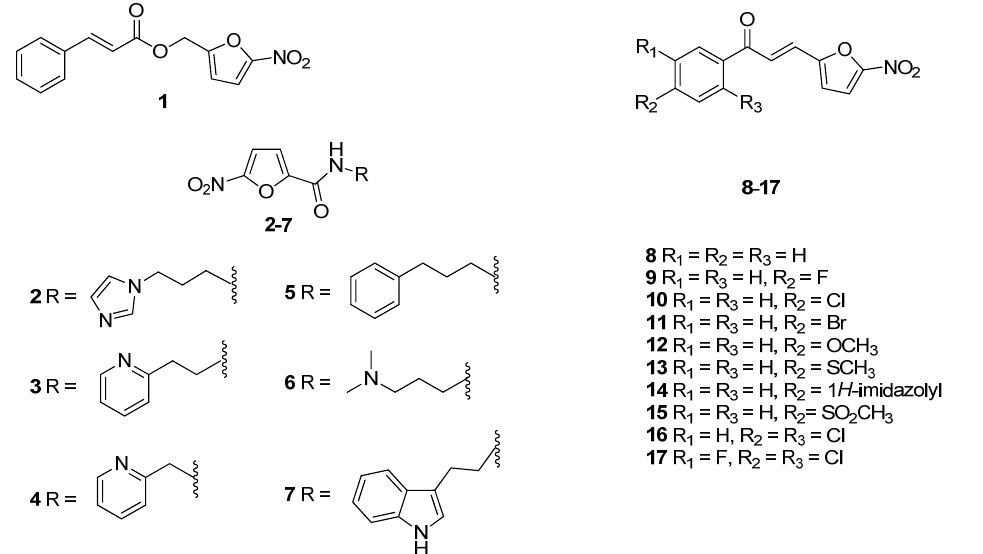
Figure 1. The nitrofuran derivatives, 1–17 , as studied in this